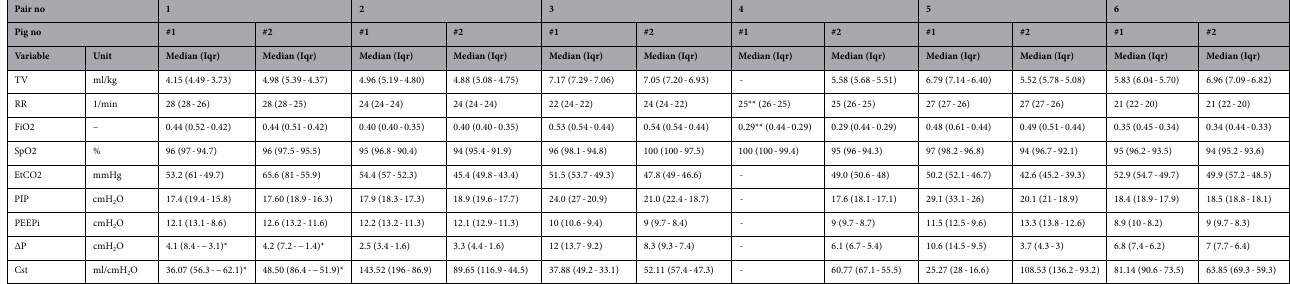
The analysis of CT scans showed that, generally, Ventil together with a ventilator or anesthetic machines did not cause any severe lung injuries in ventilated animals, with one exception, namely, subject #1 in Experiment 5, which was characterized by chronic emphysema and pneumothorax before the experiment and then very low lung compliance. This animal had the highest median PIP value and ΔP value over 10 cmH 2 O. Time‑trend analysis of the selected animal experiments. In Fig. 2A,B, we present the time trends of Experiment 6. In the time trends, we marked m1 – m4 symbols indicating exemplary events related to the experiment. Marker m1 indicates the time when the Ventil flow division ratio was significantly changed to decrease EtCO 2 in subject #2 and increase it in subject #1 . Marker m2 indicates the time when RR and FiO 2 were decreased. Marker m3 indicates the time when the side on which the pigs were lying was changed. Before this, we found a rapid increase in PIP and then ΔP and a reduction in intrinsic PEEP and the static compliance Cst of subject #1 . The body temperature of this pig tended to be distinctly elevated on the side it was lying on during all the experiments. This temperature elevation probably accompanied the Cst decrease, as these rapid Cst changes disappeared after the body position was changed. The rapid decrease in Cst on #1 did not cause significant changes in the ventilation of subject #2. Marker m4 shows the end of the experiment and the moment pig #1 was disconnected, and a 2-L respiratory bag was terminated to the breathing circuit. This resulted in a tidal volume increase for pig #2, which was followed by an increase in PIP and a decrease in EtCO 2 . This phenomenon we also found in a second experiment is described in the next paragraph. The time trends of experiment no. 3 are presented in Fig. 2C. Marker S1 indicates the injection of the first 100 ml of saline into the lungs of pig #1 . It caused a gradual increase in PIP in pig #1 , while in pig #2 , the ventila- tory parameters were not changed significantly. Marker p1 indicates the time when the ventilatory parameters were changed. Markers p2 and p3 indicate the time periods when a 2-L respiratory bag was connected instead of pigs #1 and #2 , respectively. Marker S2 indicates the injection of the second 100 ml portion of saline into pig #1 . This caused the next gradual increase in PIP in this subject. However, it did not affect the ventilation of pig #2 . Marker p4 is the time when the side on which the pigs were lying was changed from right to left. Marker p5 indicates the disconnection of pig #1 and the connection of the 2-L respiratory bag into the breathing circuit. Arterial blood gas analysis in animal experiments. The results of the ABG parameters examined for the Friedman ANOVA test are presented in Fig. 3. The comparison of all ABG samples in the WS and WD groups showed that statistically significant differences between groups were found in relation to pH , pO 2 , and SaO 2 (Table 3). The presented results show the connection between those parameters according to the well-known acid–base equilibrium model, and there is confirmation of the reliability and validity of the research approach. The observations concerning steady changes in the time of AGB parameters in groups WS and WD showed that there was no statistically significant difference between the values of these parameters over time (independent variable) (Table 3). Despite the lack of these statistically significant differences, in the WD group, Be(ecf) showed a positive Spearman correlation coefficient (r = 0.433), which means that the Be(ecf) values increased over time during the experiments. In relation to the WS group, the Spearman correlation coefficients were also positive for cHCO 3− and Be(ecf) (0.509 and 0.561, respectively). In the WS group, the opposite trend was found for lactate levels (r = − 0.393), which means that lactate values decreased over time. Laboratory experiments: effects of changing resistance and compliance in one artificial lung on flow and pressure in the second lung. We performed the tests of mechanical property changes (named later ’events’) in a first artificial lung ( AL ) to the flow and pressure changes in a second AL (the scheme